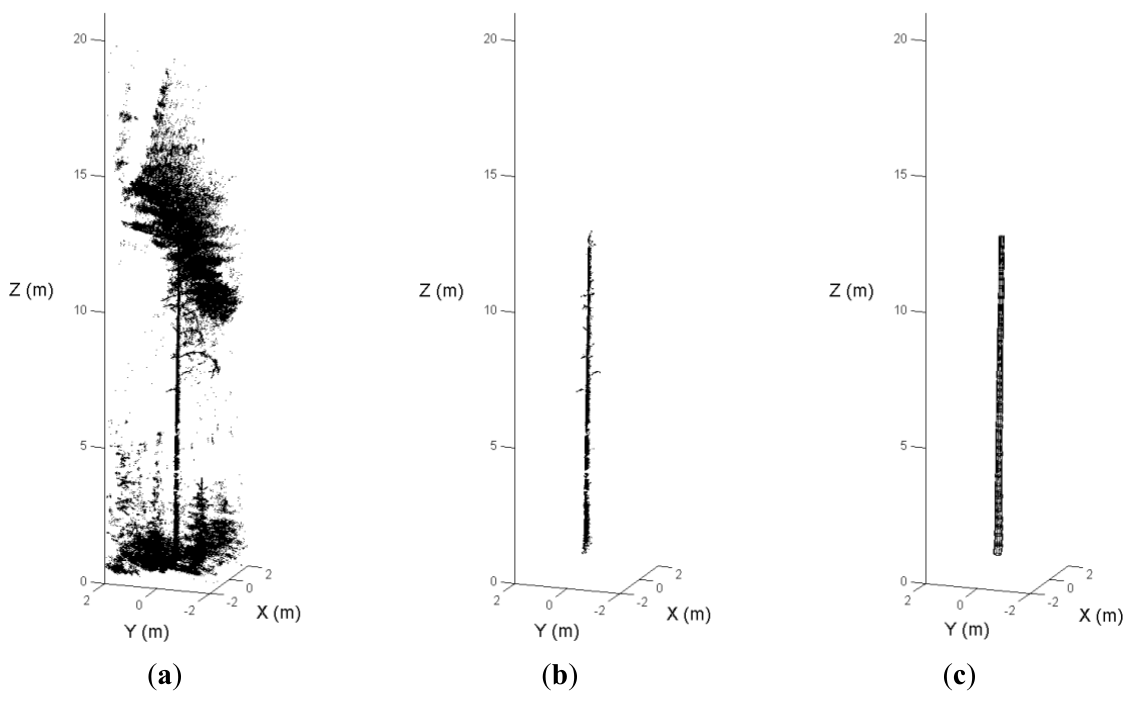
Figure 7. The automated stem reconstruction: ( a ) the original point clouds of a tree; ( b ) the detected stem points; and ( c ) the scan model automatically